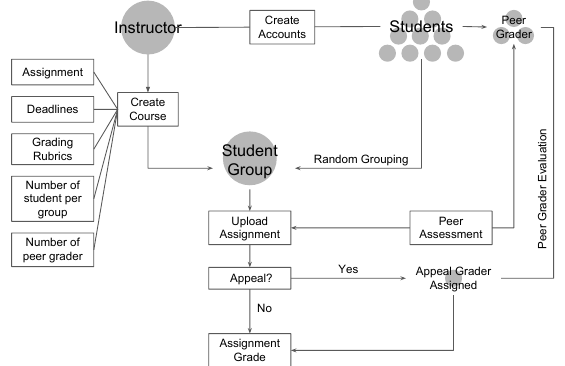
Figure 3. Logical flow of how the instructor and students use SmartGroup. Note that human users are represented by grey circles, and actions that require human input are boxed with white backgrounds. Lines denote system elements that facilitate and connect human